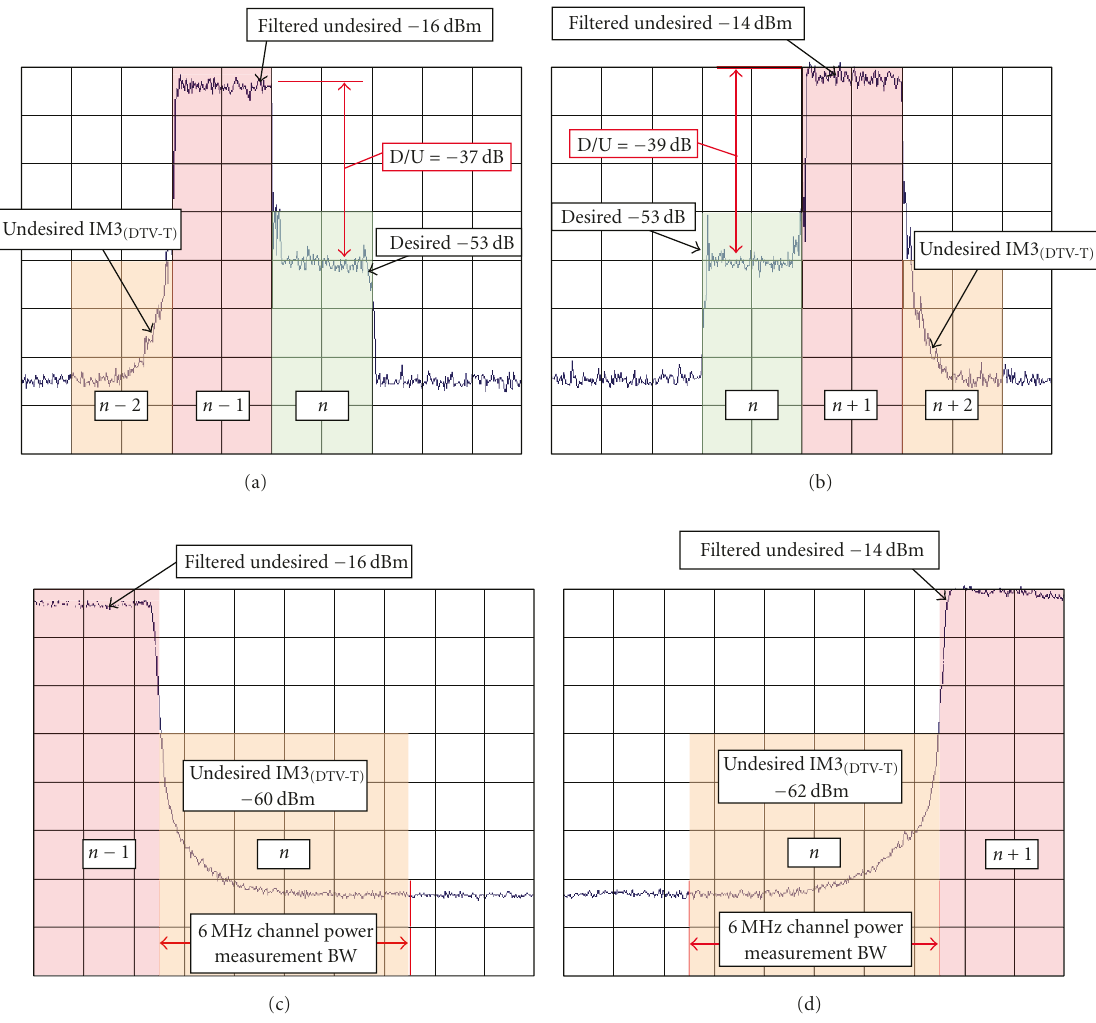
Figure 8: (a) n = − 53dBm; undesired signal at n − 1; minimum IM 3(DTV-T) configuration (b) n = − 53 dBm; undesired signal at n + 1; minimum IM 3(DTV-T) configuration (c) IM 3(DTV-T) level present in desired channel n . undesired signal at n-1; Minimum IM 3(DTV-T) Configuration. (d) IM 3(DTV-T) Level Present in Desired Channel n . Undesired Signal at n + 1; Minimum IM 3(DTV-T)